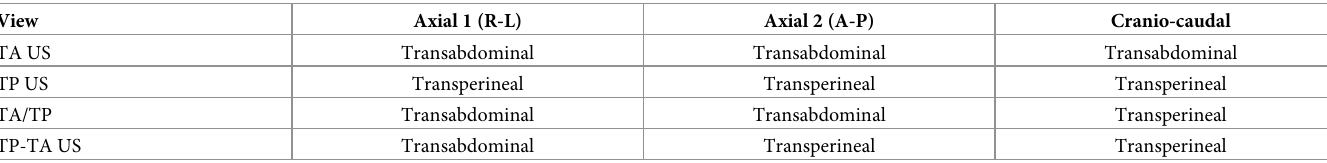
Table 1. US views acquired for deriving prostate